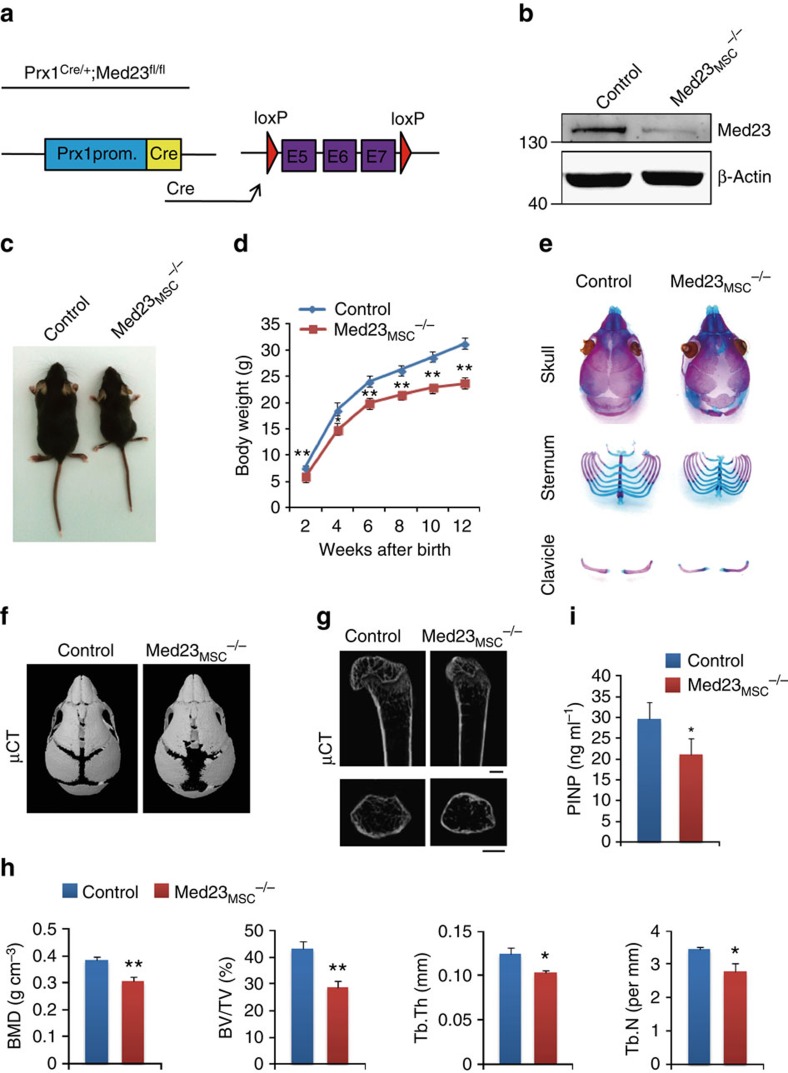
Inactivation of Med23 in mesenchymal stem cells causes impaired bone ossification.(a) Illustration of Med23 deletion in Prx1-expressing mesenchymal stem cells. (b) Expression of Med23 protein in bone marrow-derived mesenchymal stem cells from 6- to 8-week-old control (Med23fl/fl) and Med23MSC−/− mice. (c) Representative view of 1-month-old control and Med23MSC−/− mice. (d) Body weight of male control mice and Med23MSC−/− littermates measured at different age points (n=3 for each group, t-test). Data represent means±s.d. *P<0.05, **P<0.01. (e) Skeletal preparations from control and Med23MSC−/− newborns were double stained with Alizarin red and Alcian blue. (f) Microcomputed tomography (μCT) image of skulls from control and Med23MSC−/− mice at postnatal day 6 (P6). (g) μCT images of distal femurs from 1-month-old control and Med23MSC−/− mice (top panel, longitudinal view; bottom panel, axial view of the metaphyseal region). Scale bar, 1 mm. (h) Quantitative μCT analysis of distal femurs from 1-month-old control (n=5) and Med23MSC−/− mice (n=4), including bone mass density (BMD), bone volume per tissue volume (BV/TV), trabecular thickness (Tb.Th) and trabecular number (Tb.N). Data represent means±s.e.m. t-test,*P<0.05, **P<0.01. (i) ELISA analysis of serum PINP (ng ml−1) from 1-month-old control and Med23MSC−/− mice (n=4). Data represent means±s.d. t-test, *P<0.05, **P<0.01.